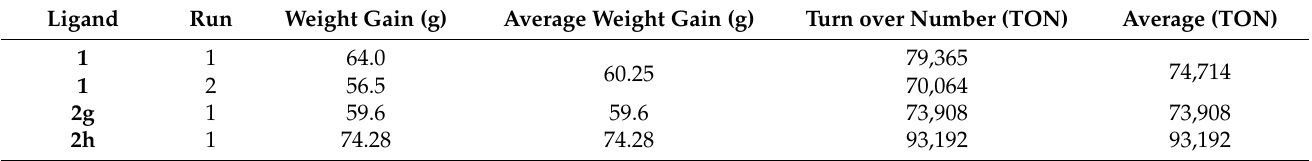
Table 3. Pd-based catalysis with ferrocenyl phosphine ligand substituted on the lower ring with silyl groups. The graphic shows the palladium dichloride complex, 1 (cid:48) -triphenylsilyl-bis-1,2-(di- t butylphosphinomethyl)ferrocene, and catalyst precursor.